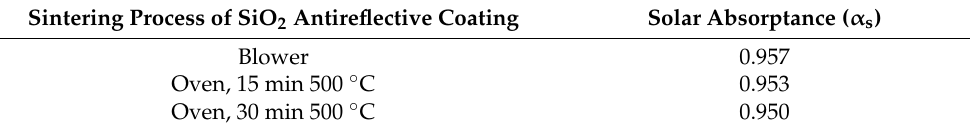
Table 3. Solar absorptance values of Al/CuMnO x /CuFeMnO x /SiO 2 samples with different sintering processes of the silica layer.